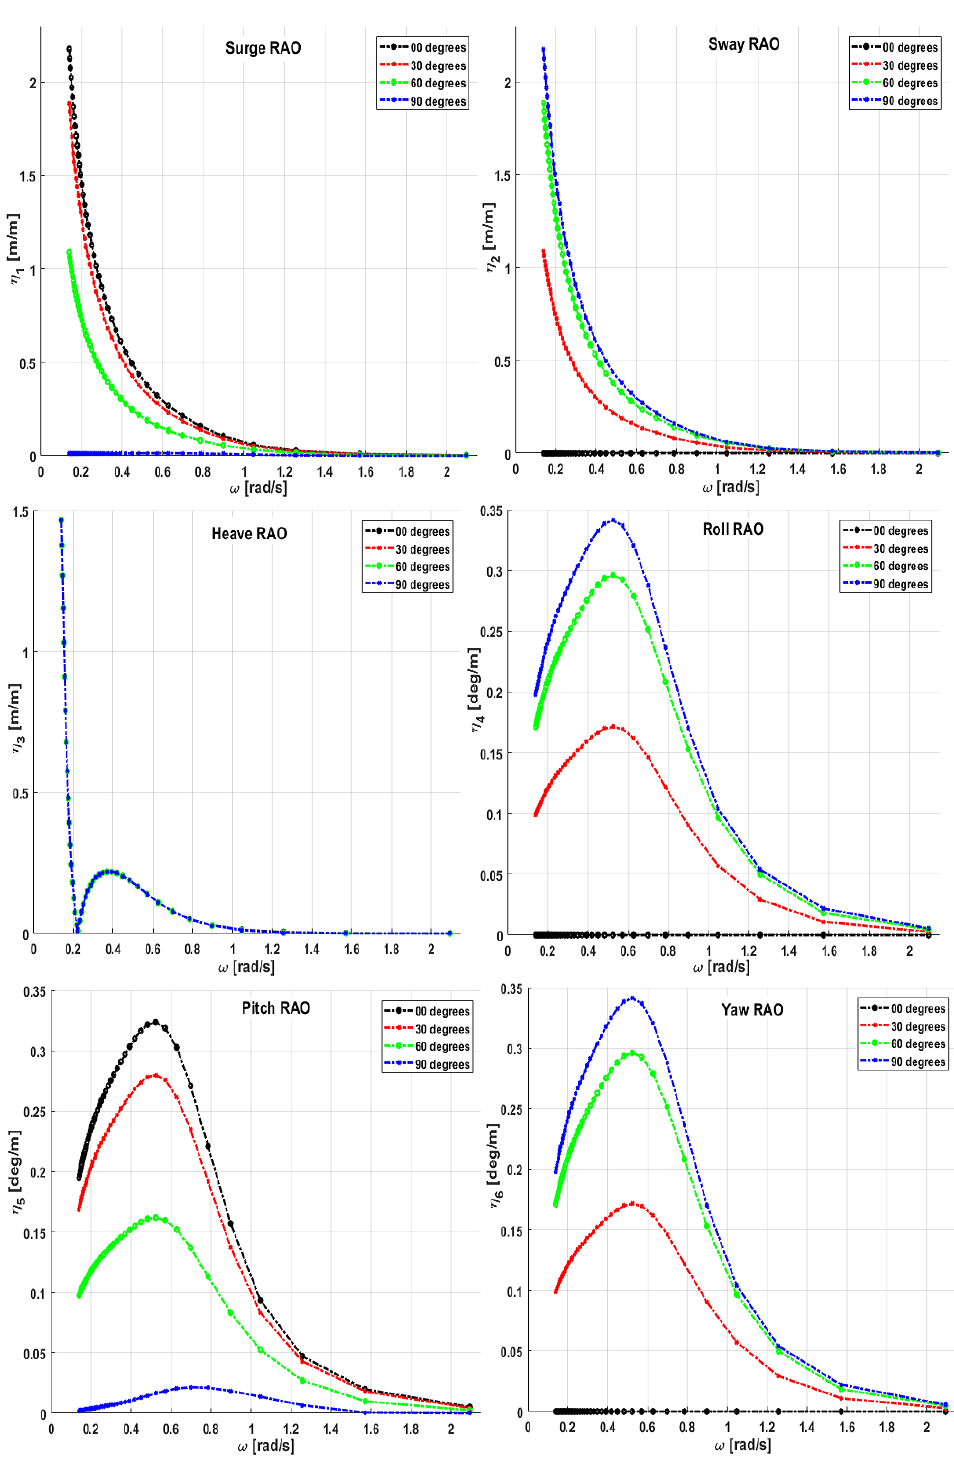
Figure 5. Frequency domain RAOs for several wave incidences.